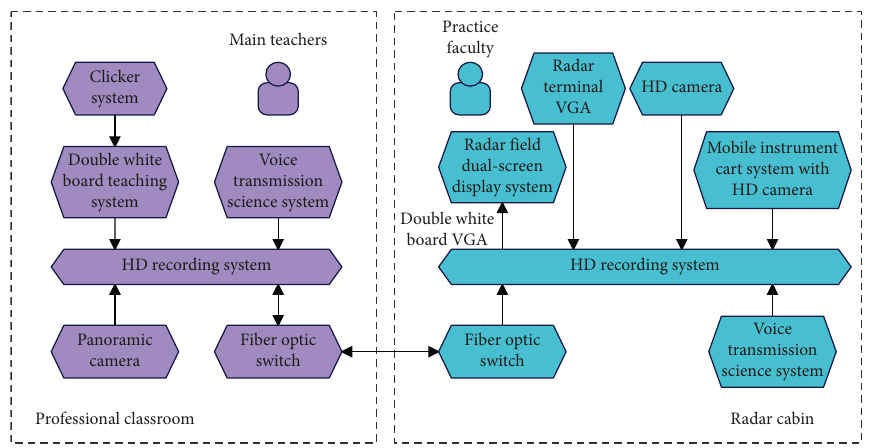
Figure 7: Architecture of the distributed interactive teaching system.